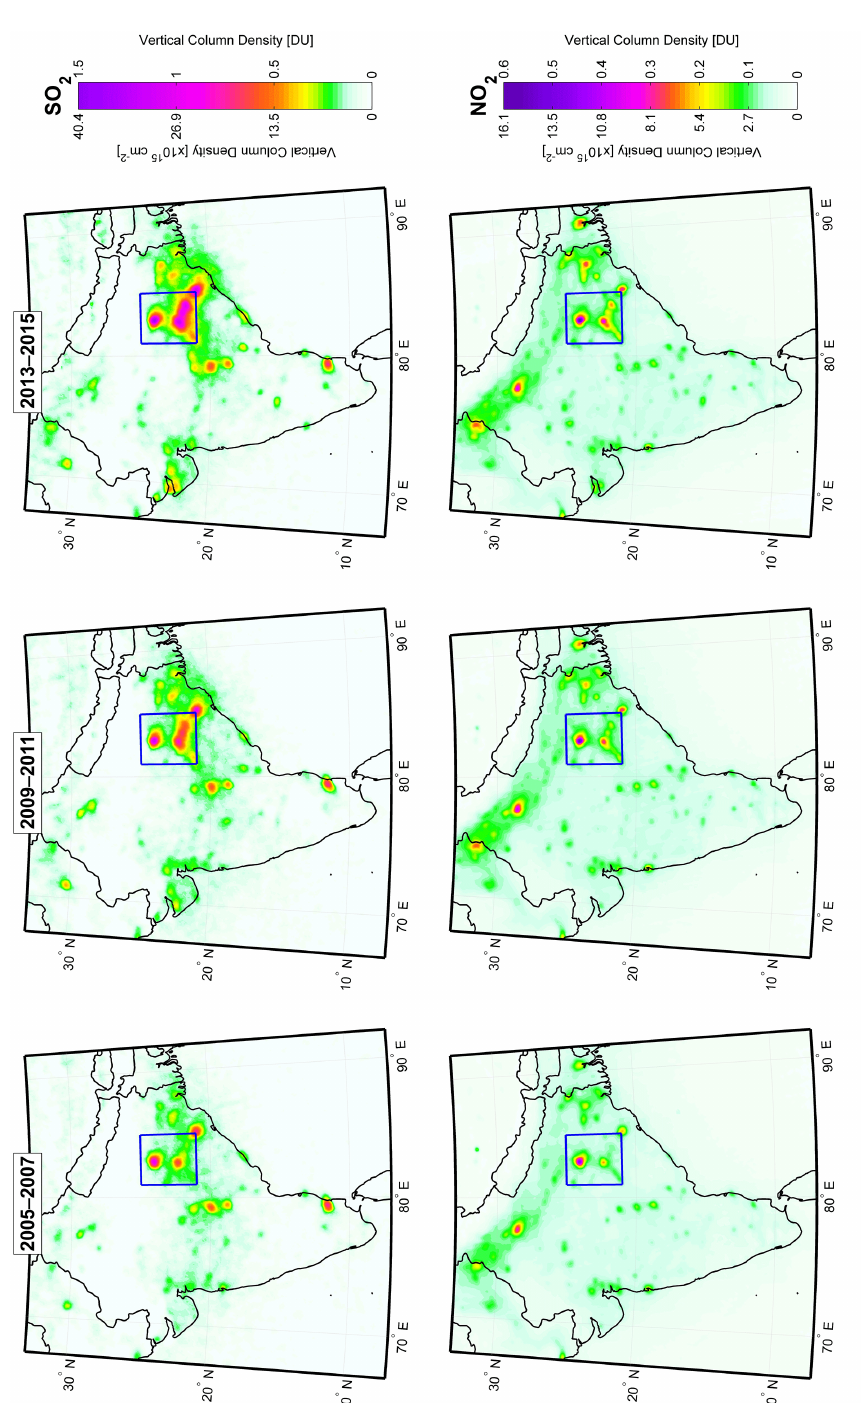
Figure 6. Similar to Fig. 2 but for India. The blue box outlines the industrial regions in Chhattisgarh and Odisha, which combine to represent one of India’s most active areas in terms of building new coal-fired power plants. The region is shown in Fig. 3.